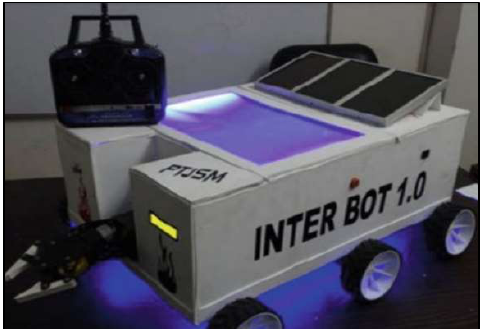
Fig. 4. Smart Surveillance Bot With Real-Time Monitoring [4] 3 System Block Diagram